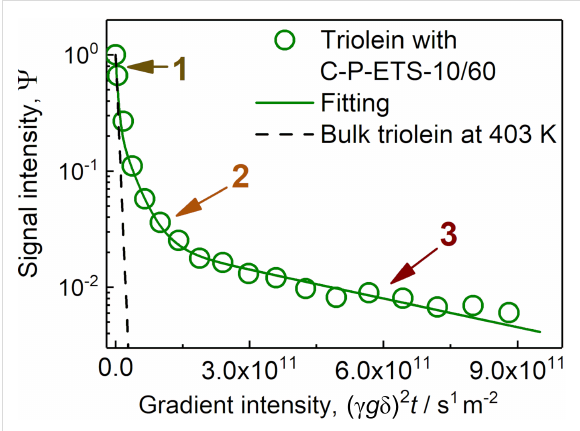
Figure 16: 1 H PFG NMR diffusion attenuation curves of bulk triolein (dashed line) and triolein in oversaturated C-P-ETS-10/60 titanosili- cate at 403 K. The solid line represents converged fitting using Equa- tion 2 with i = 3. The ranges where the corresponding diffusion mode dominates are shown by the